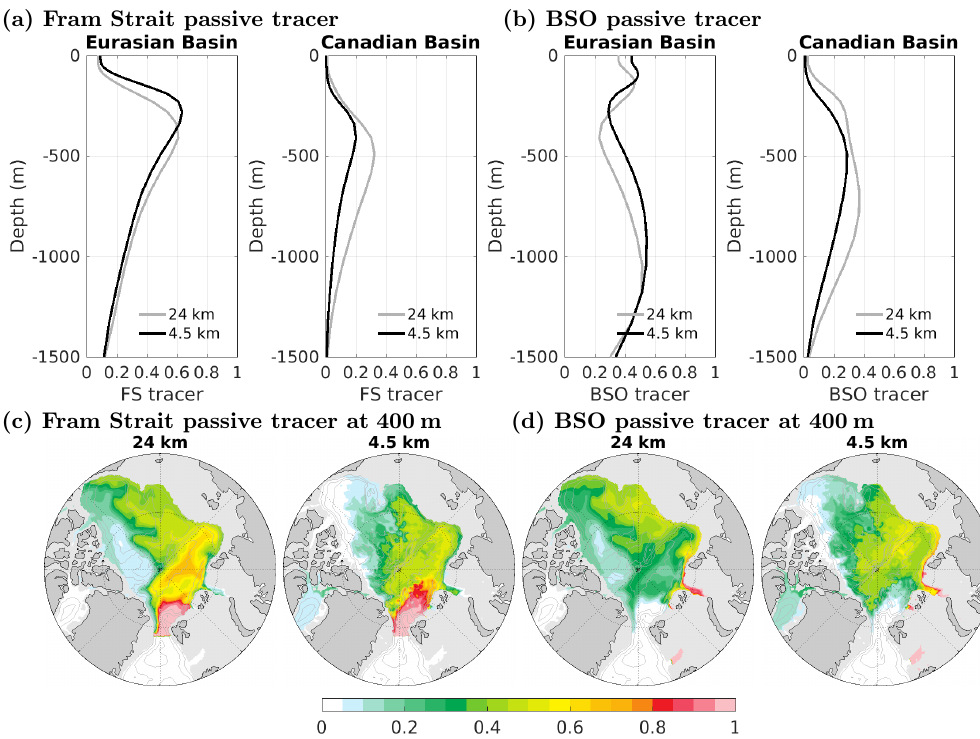
Figure 15. (a) Mean Fram Strait passive tracer concentration in the two Arctic basins averaged over the year 2000. (b) The same as panel (a) but for the BSO passive tracer. (c) The Fram Strait passive tracer at 400m depth averaged over the year 2000. (d) The same as panel (c) but for the BSO passive